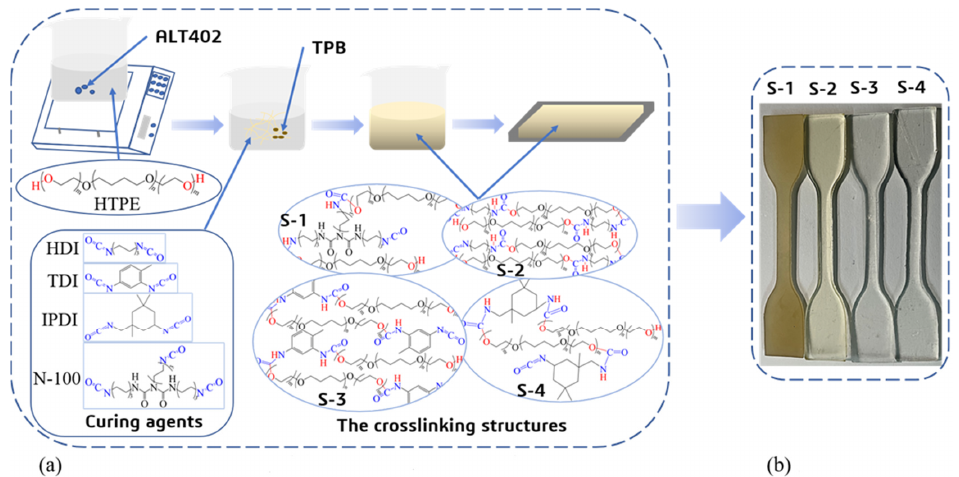
Figure 3. The simplified experimental routes to process the HTPE binders. ( a ) the diagram illustration of the preparation process of HTPE binders; ( b ) the HTPE binders.